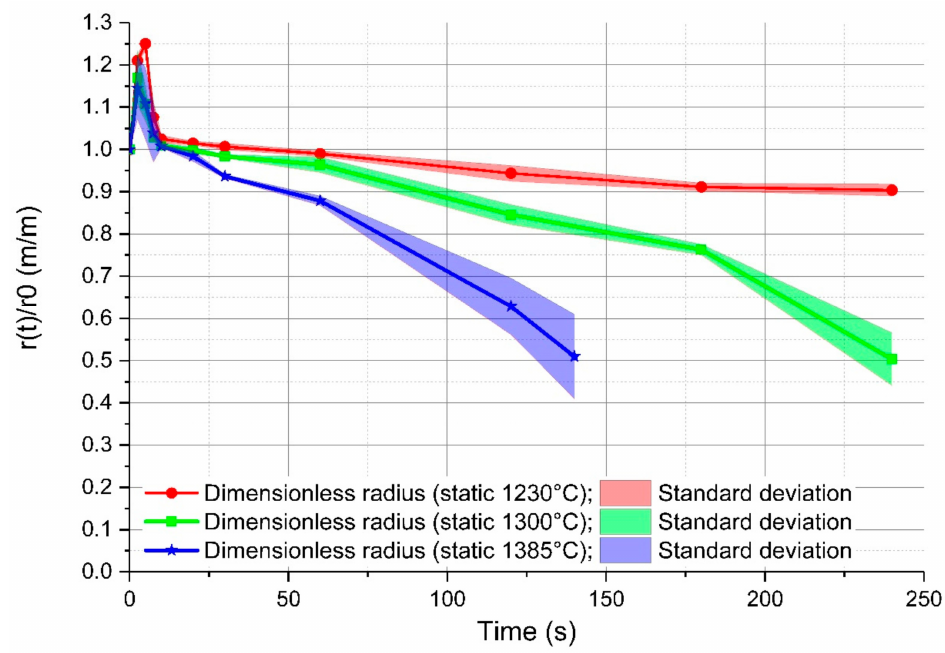
Figure 3. E ff ect of bath temperature on the melting rate of cylindrical scrap samples in hot metal.